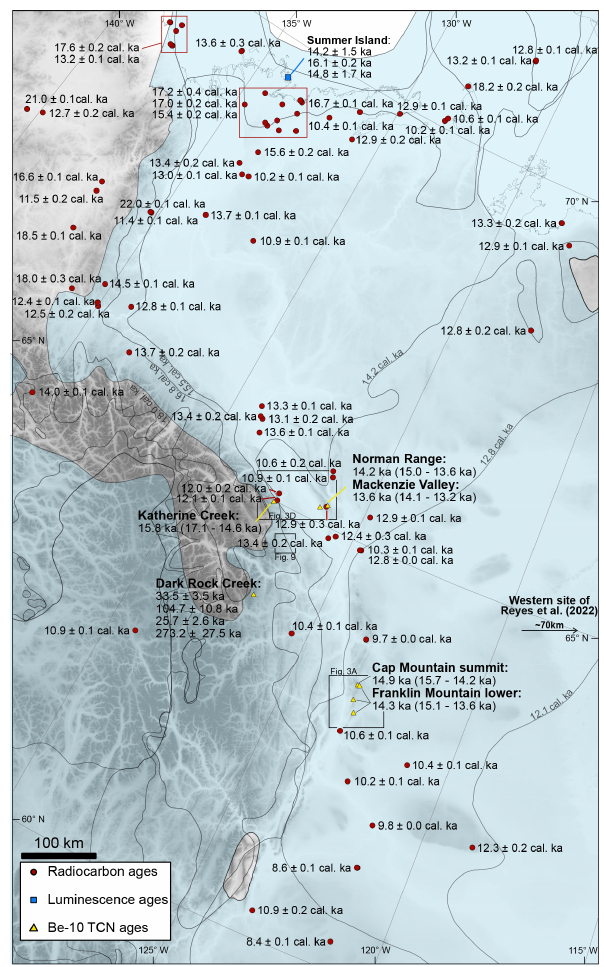
Figure 2. The distribution of chronological constraints on the deglaciation of the NW sector of the Laurentide Ice Sheet. The pat- tern of deglaciation is depicted by grey lines, and the shaded blue area represents the local LGM limit at 18.0kacalBP (Dalton et al., 2020). For our new TCN exposure ages, we present the mean site deglaciation ages (2 σ range) calculated from our Bayesian mod- elling. Radiocarbon ages were selected from the database of Dalton et al. (2020) and recalculated using the IntCal20 curve (Reimer et al., 2020). Radiocarbon ages in the red boxes have been grouped together; the ages next to the red boxes are the three oldest radio- carbon ages in the grouping. We only present the oldest OSL ages from post-glacial sediments in the Mackenzie Delta region (Bate- man and Murton, 2006; Murton et al., 2007, 2010,